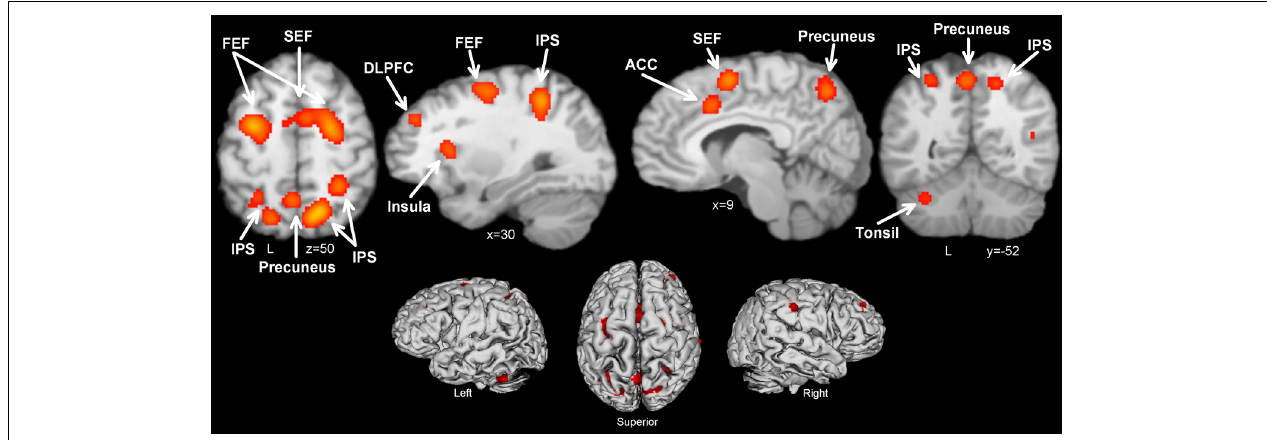
FIGURE 2 | Activation likelihood maps for antisaccade > prosaccade. Abbreviations: FEF, frontal eye field; SEF, supplementary eye field; SPL, superior parietal lobule; DLPFC, dorsolateral prefrontal cortex; IPS, intraparietal sulcus; ACC, anterior cingulate